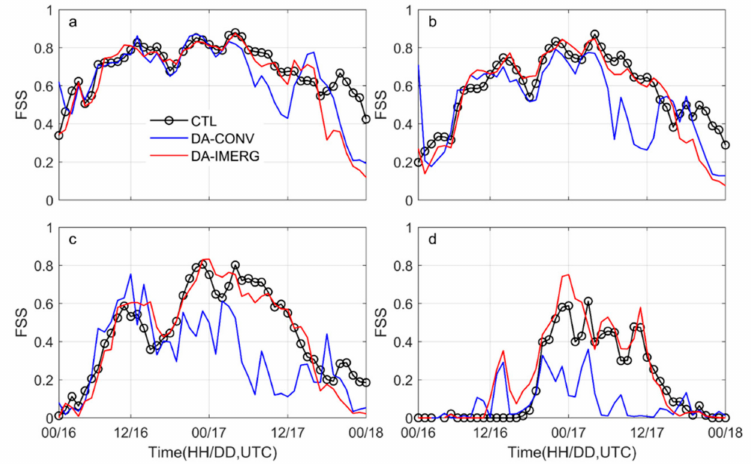
Figure 12. Fractions skill scores for the hourly precipitation threshold of ( a ) 1.0 mm / h, ( b ) 2.5 mm / h, ( c ) 5.0 mm / h, and ( d ) 10 mm / h at grid scale in the domain D2 for the TC Rumbia. The precipitation observation used in the score is from the